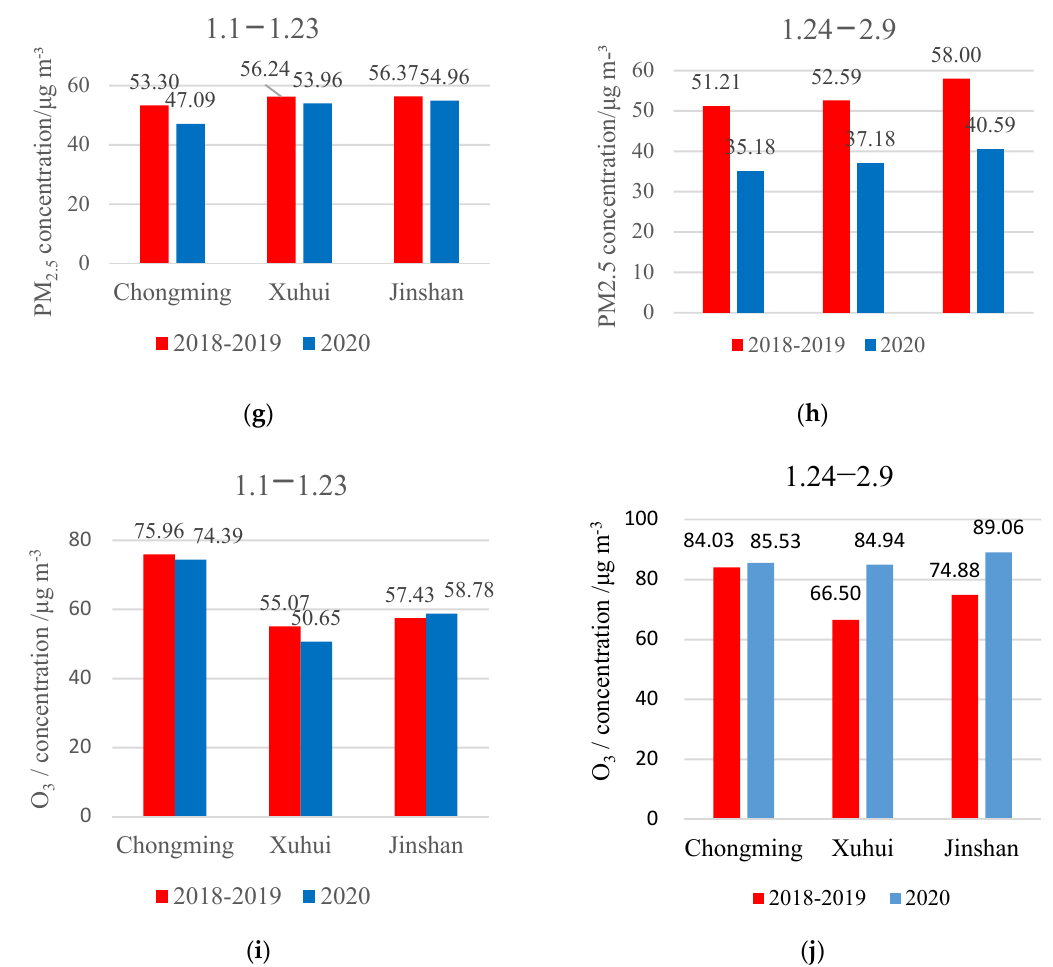
Figure 4. Average concentrations of different pollutants before (1.1–1.23) and during COVID-19 lockdown (1.24–2.9) in different years in Shanghai: The data on each panel are the average concentrations of each pollutant on the corresponding date. ( a )–( j ) are respective comparison of SO 2, NO 2, PM 2.5 , PM 10 abd O 3.